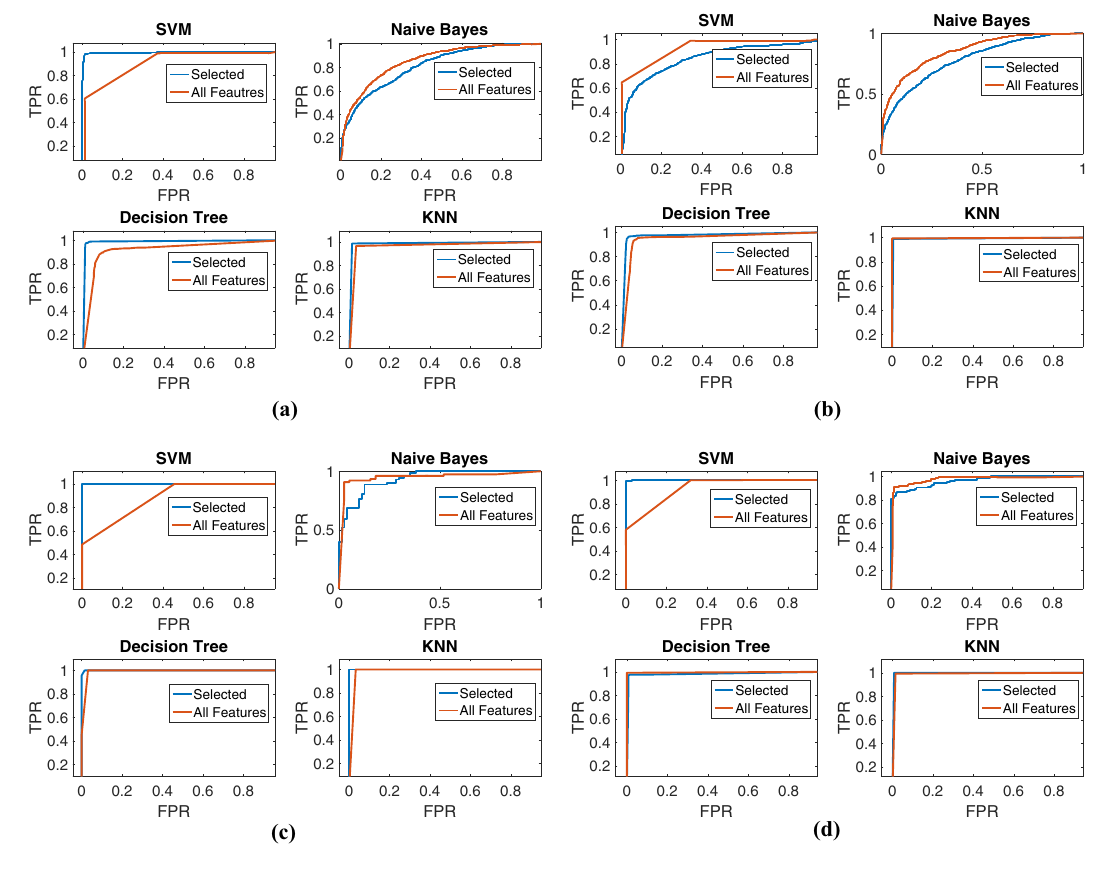
Figure 5 ROC curves of comparison results with different models using the selected features and all features in LLC